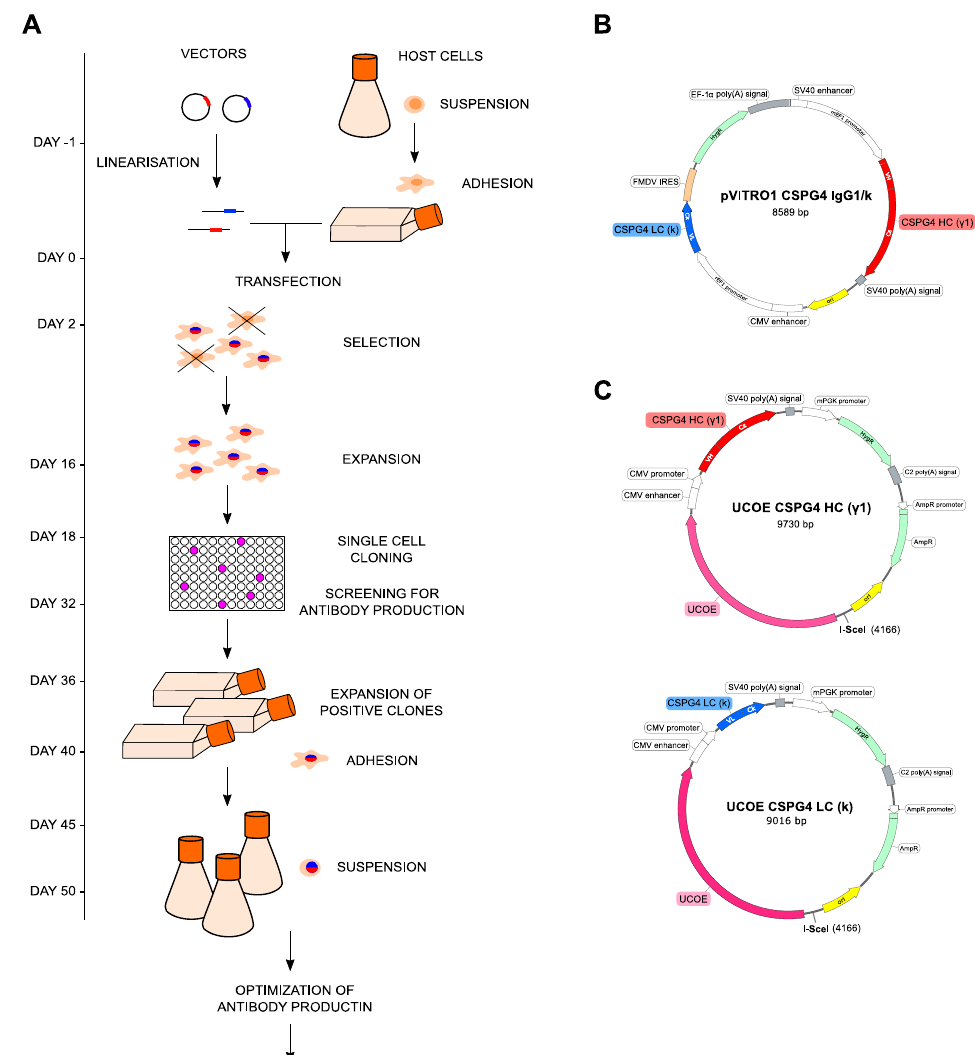
Figure 1. Generation of the anti-CSPG4-IgG1 antibody. ( A ) Schematic diagram summarizing the development of stable cell lines expressing anti-CPSG4 IgG. Vectors were linearized before transfection to allow correct integration into the host genome, and transgene-expressing cells were selected; ( B ) pVITRO1-CSPG4-IgG1 / κ vector map; ( C ) UCOE-CSPG4-HC( γ 1) and UCOE-CSPG4-LC ( κ ) vector maps.